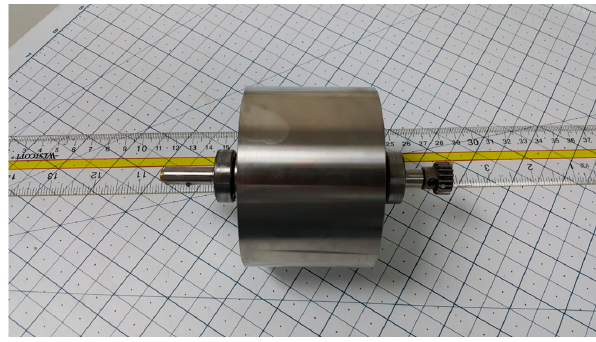
Figure 4. Experimental apparatus rotor test hardware.